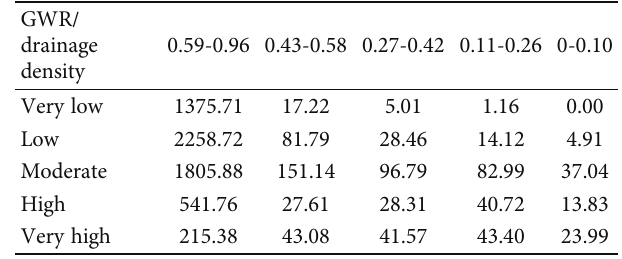
Table 10: Cross-tabulation between GWR and drainage